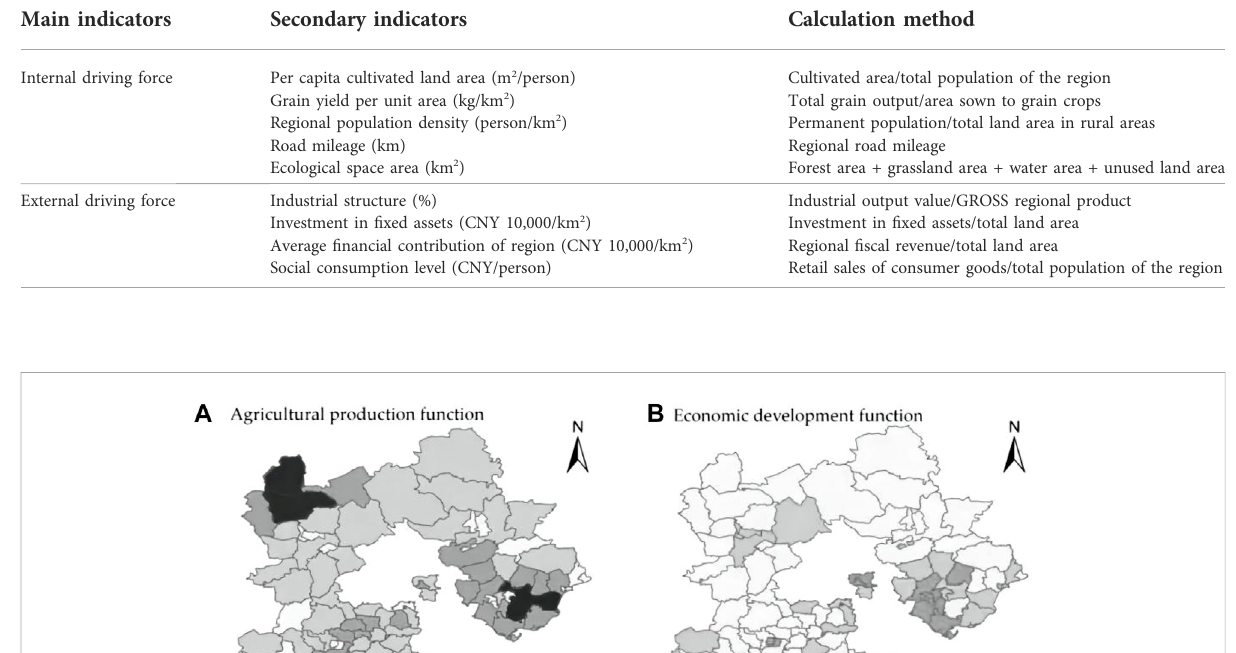
TABLE 2 Index system of in fl uencing factors of rural-area multi-functionality evolution.